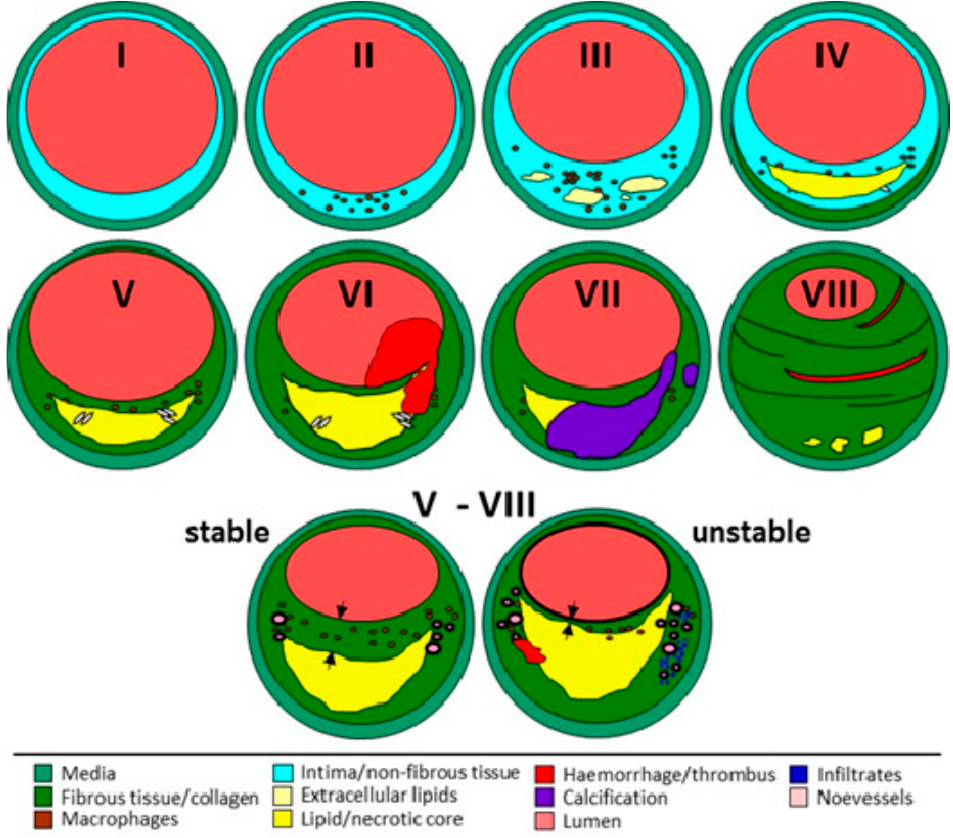
Figure 4. Classification of atherosclerotic lesions according to the American Heart Association (AHA) [24–27]. Type I: initial lesion with isolated macrophages and macrophage-derived foam cells; type II: fatty streaks, increased number of foam cells, intracellular lipid accumulation; type III: further accumulation of inflammatory cells and intracellular lipids, isolated extracellular lipid deposits; type IV: atheroma, formation of confluent lipid core without perceptible fibrous cap; type V: fibroatheroma, formation of fibrous layer over the lipid/necrotic core; type VI: as V but with thrombus and/or intraplaque hemorrhage; type VII: as V with calcified nodules, calcification predominates; type VIII: fibrous tissue predominates, lumen mainly small, lipid deposits minimal or absent. Plaque stability was assessed in line with [28]: thin fibrous cap <>200 µm (arrows) over a larger necrotic core. Unstable/vulnerable plaque can develop from each plaque type of type V–VIII. Modified from [29].